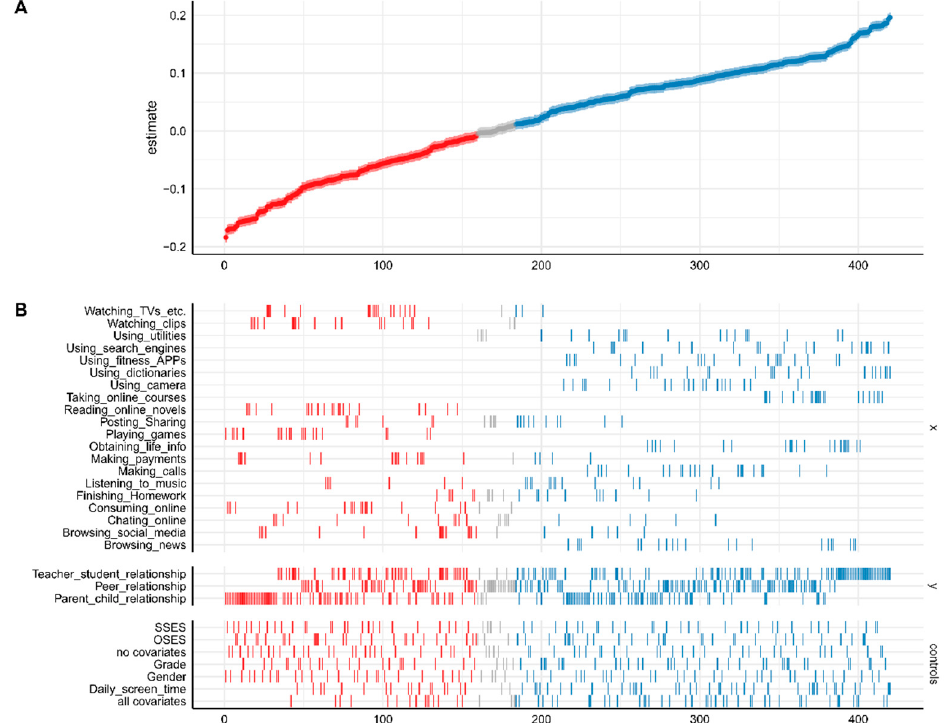
Figure 2. Description of SCA. The estimate denotes the standardized regression coefficients calculated via linear regression; the x -axis indicates the combined number of specifications, and the y -axis of ( B ) refers to all variables used in the analysis. Red dots denote negative and significant effects (based on the chosen significance level; by default, α = 0.05). Blue dots signal positive and significant effects. Gray dots indicate insignificant effects. The coefficients in ( A ) depict a curve, and the dashed area around the curve denotes the 95% CIs for the standardized regression coefficients. Daily screen time means smartphone use time each day; SSES is subjective SES, and OSES is objective SES.